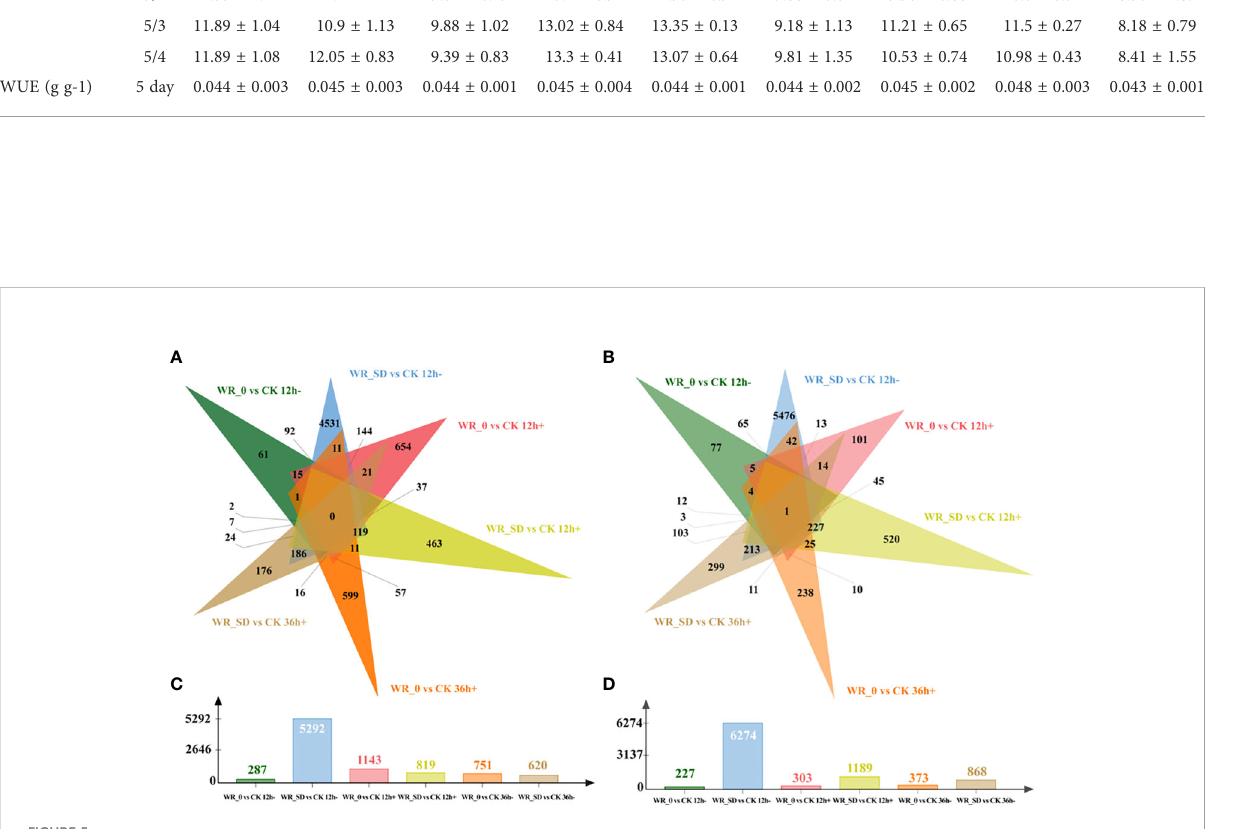
drought period in the WR_SD treatment (~42%, Figure 4A), followed by Xiangye (~37%, Figure 4B) and Zhangji (~31%, Figure 4C), but was different for E (Zhangji: reduced by ~41%, Figure 4D; Hongyan: reduced by ~34%, Figure 4E; Xiangye: reduced by ~31%, Figure 4F). After water recovery, the Tr m and E of WR_ q cri recovered rapidly to levels similar to those of CK, where Tr m and E only decreased by ~2% averaged for the three varieties across the water recovery phase (Figure 4). In accordance with Tr m and E during the progressive drought phase, the recovery of Tr m was poorest for Hongyan (reduced by ~29%, Figure 4A), followed by Xiangye (~18%, Figure 4B)